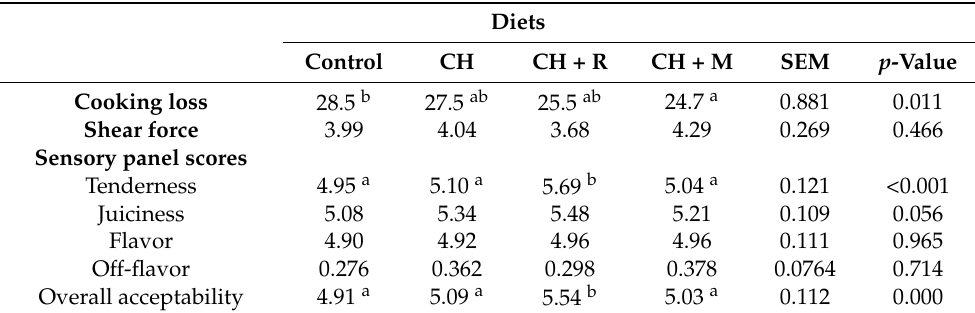
Table 4. Effect of experimental diets on cooking loss (%), shear force (kg) and sensory panel analysis in longissimus lumborum . Diets Control CH CH + R CH + M SEM p -Value Cooking loss 28.5